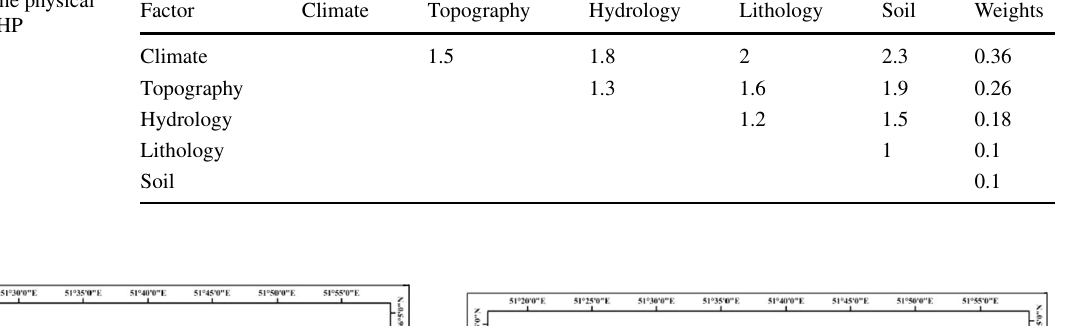
Table 1 Weights of the physical factor assigned by AHP